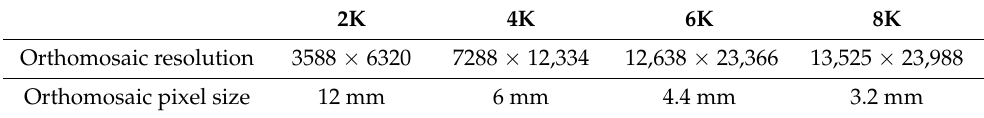
Table 4. Orthomosaic resolution and pixel size of the second